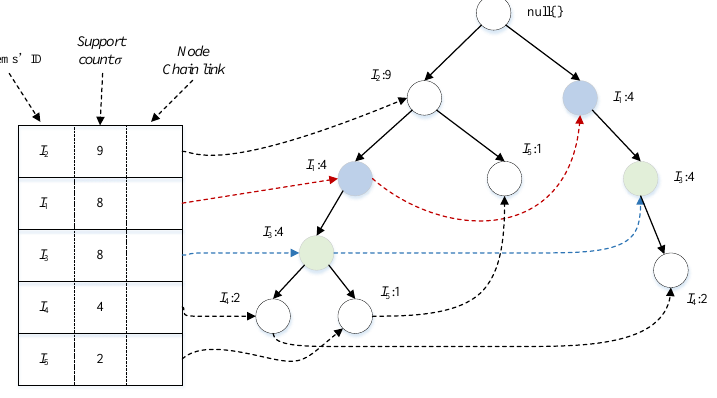
Figure 3. Pattern mining purpose.